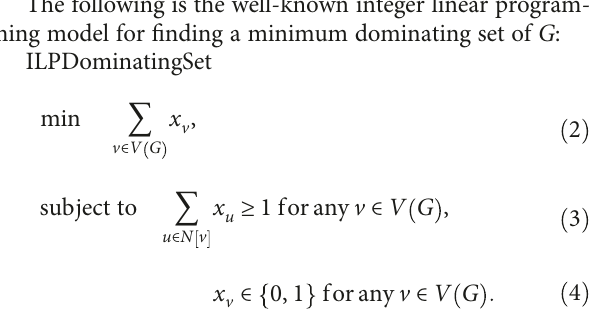
Figure 1: A dominating set with 95 vertices in C